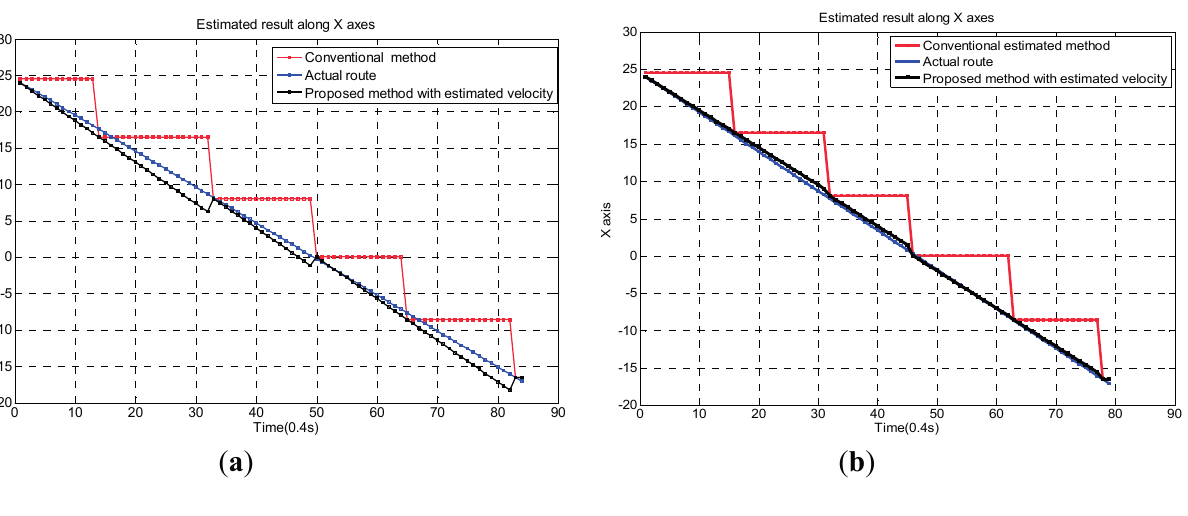
Table 2 . Estimated mean errors in the non-overlapping